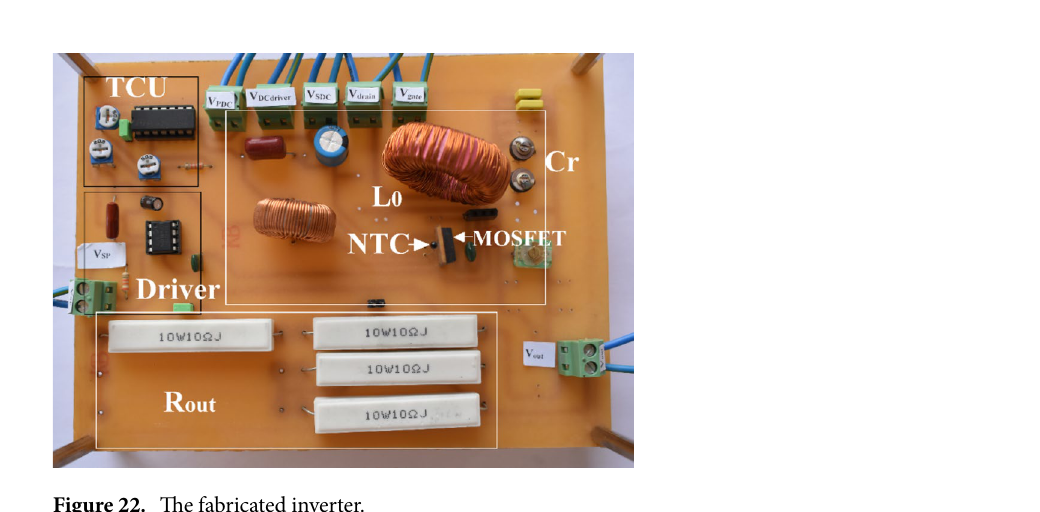
Figure 22. The fabricated